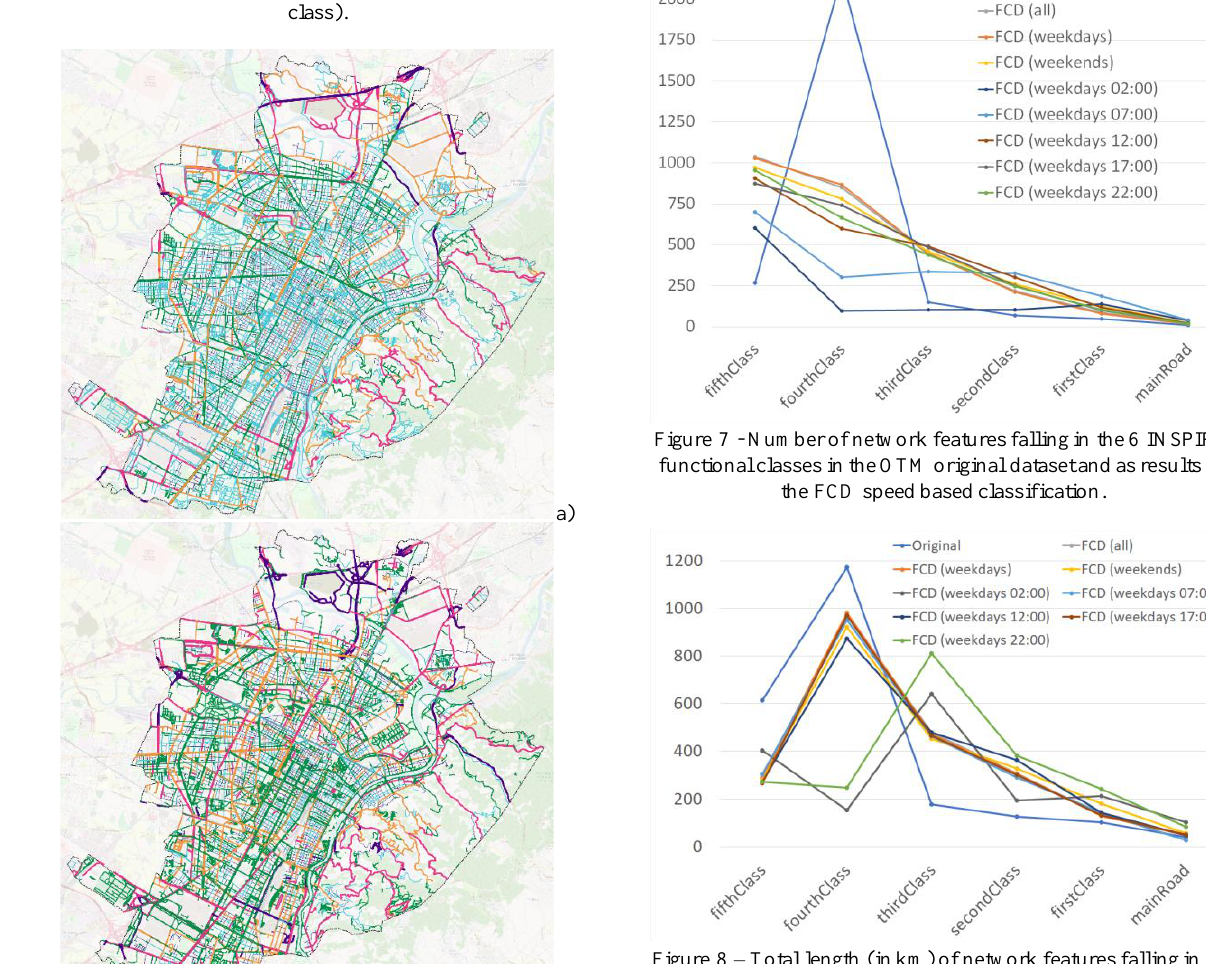
Figure 6 - Different results of a routing calculation if run in a 7:00 AM situation (red line) or a 10:00 OM one (blue line). Figure 4 - Functional classes based on mean speed classification (in square brackets the number of network elements in each class).